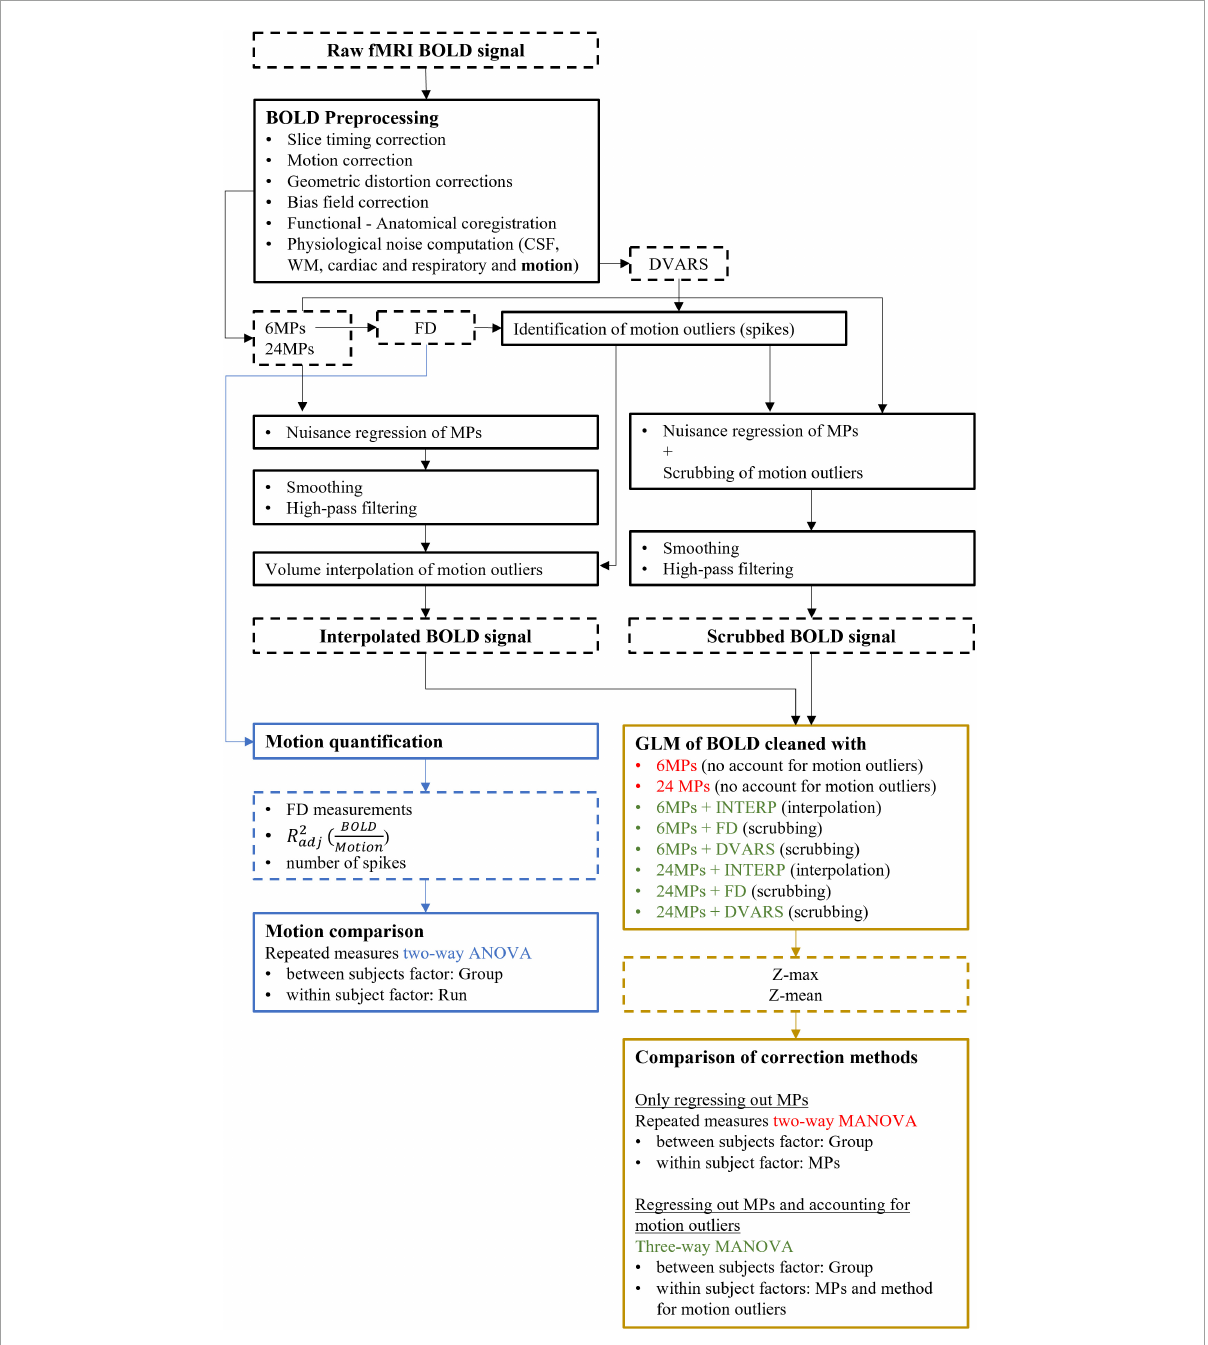
FIGURE2 Workflow describing the methodology applied. Dashed outline and full outline boxes represent measures (outputs) and processes, respectively. Blue and yellow colors are related to motion quantification/characterization analysis and comparison of correction methods, respectively.